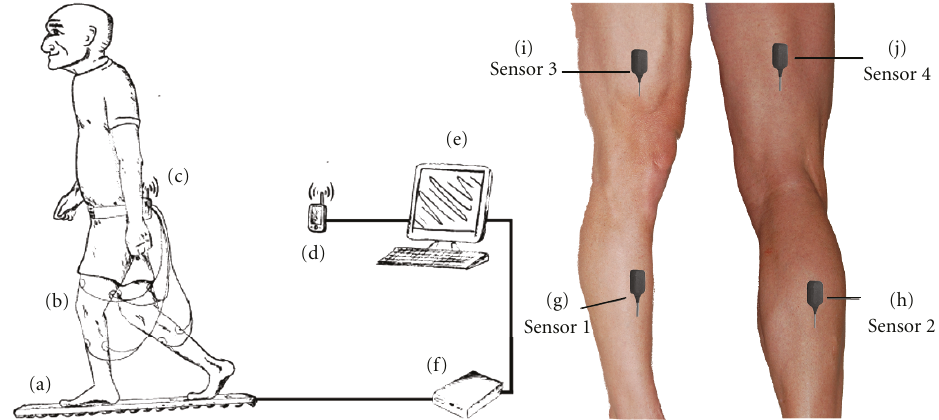
Figure 1: Diagram of data collection setup (a) pressure-sensitive walkway, (b) EMG sensors connected to muscles, (c) amplifier and wireless transmitter unit, (d) 802.11 receiver, (e) data-recording computer, (f) walkway data converter and EMG sensor locations, (g) sensor 1: tibialis anterior (h) sensor 2: gastrocnemius (i) sensor 3: vastus lateralis (j) sensor 4: biceps femoris.